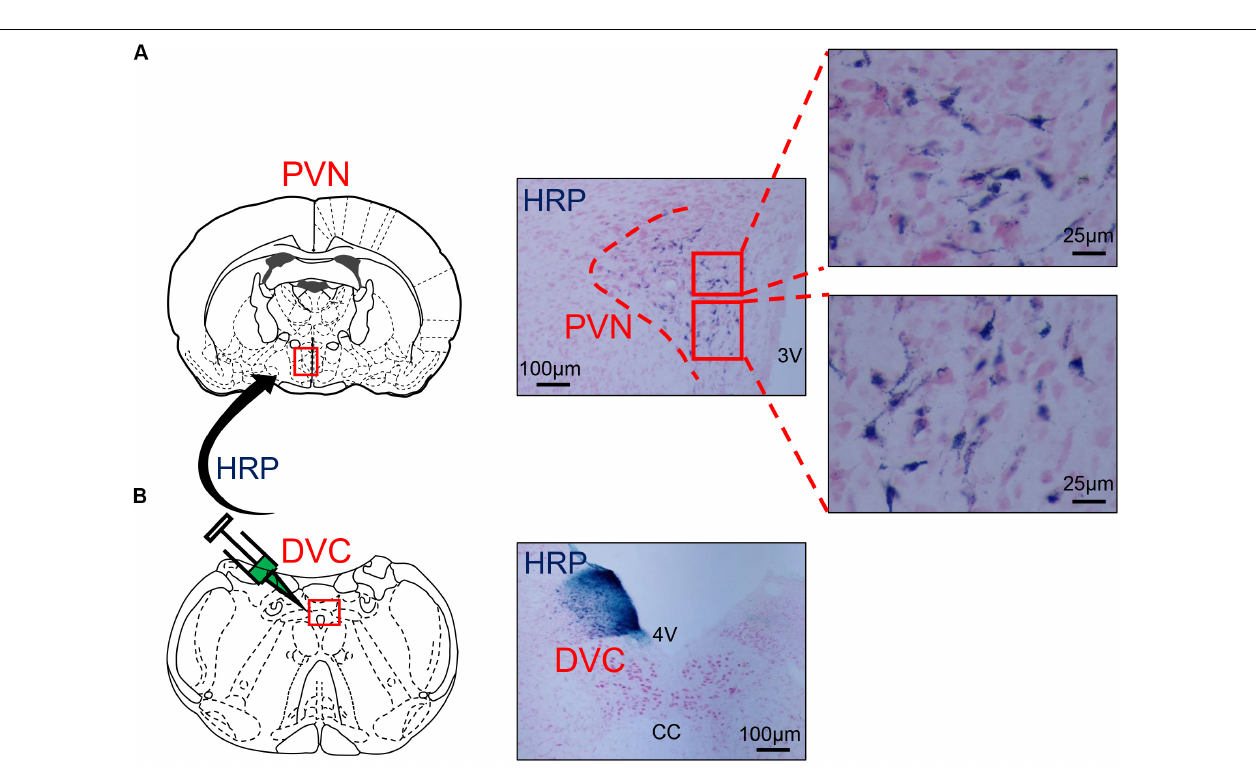
FIGURE 4 | (A) The distribution of HRP-labeled neurons in the PVN. (B) The microinjection zone of HRP in DVC. HRP injection zone could be observed on one side of DVC, and HRP retrograde-labeled neurons were densely distributed in the medial subnucleus and the lateral subnucleus of PVN and scattered in the dorsal subnucleus. PVN, paraventricular nucleus; DVC, dorsal vagal complex; 3V, third ventricle; 4V, fourth ventricle; cc, central canal; HRP, horseradish peroxidase.